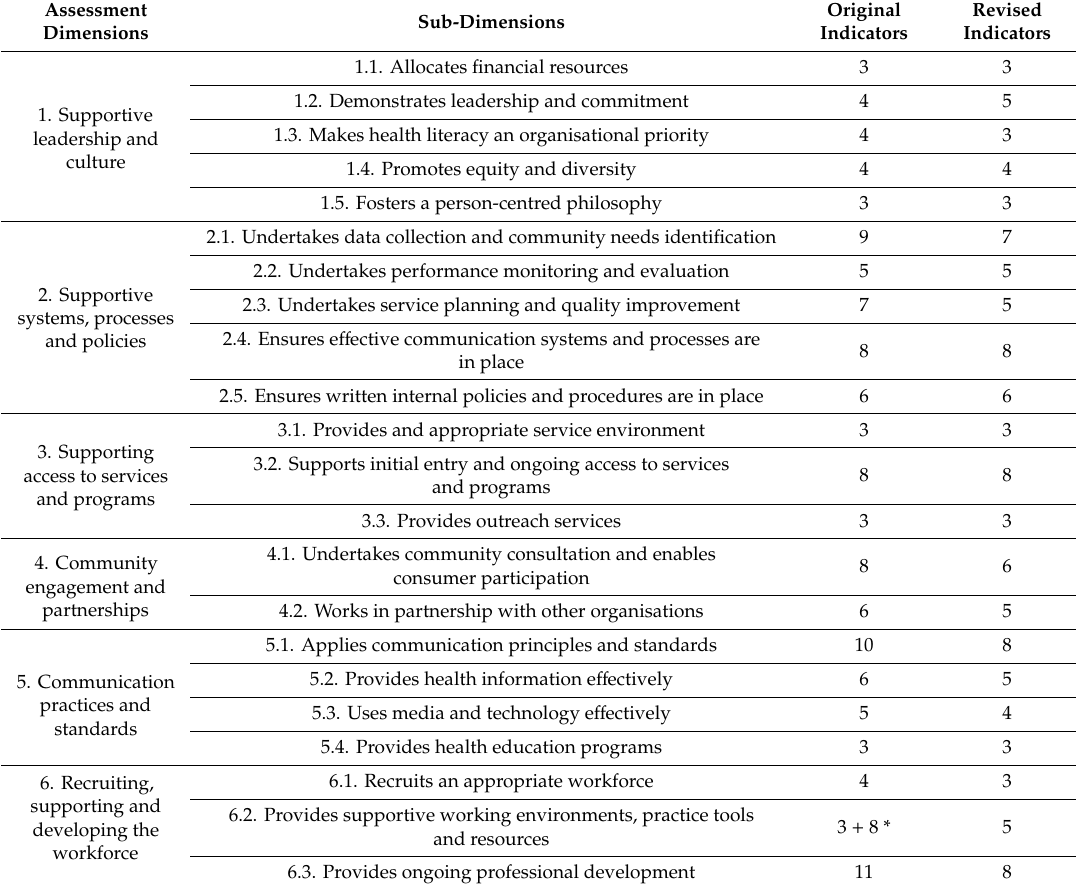
Table 6. Revised Org-HLR tool assessment dimensions, sub-dimensions and number of performance